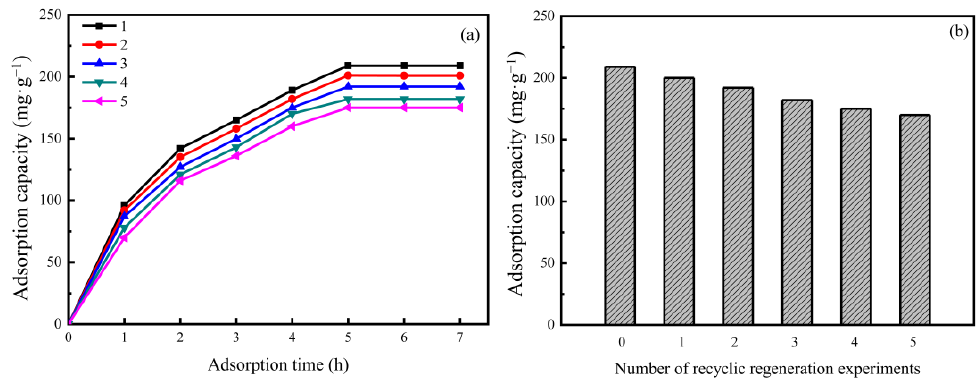
Figure 9. Desorption and regeneration experiments for the AAM-MSMPM: Effect of adsorption time at different recyclic numbers ( a ) and recyclic numbers ( b ) on the adsorption capacity.